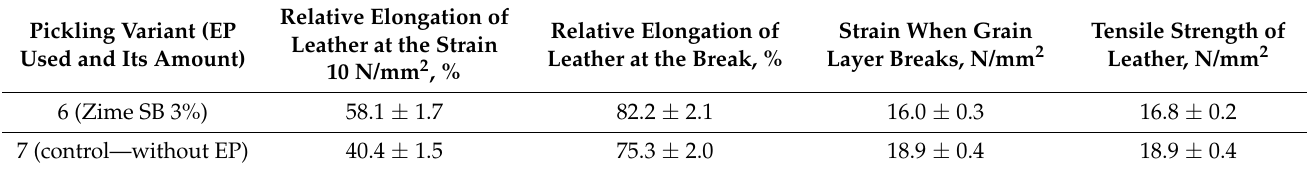
Table 4. Physical–mechanical properties of crust leather dependent on pickling method. Relative Elongation Pickling Variant (EP Used and Its Amount)